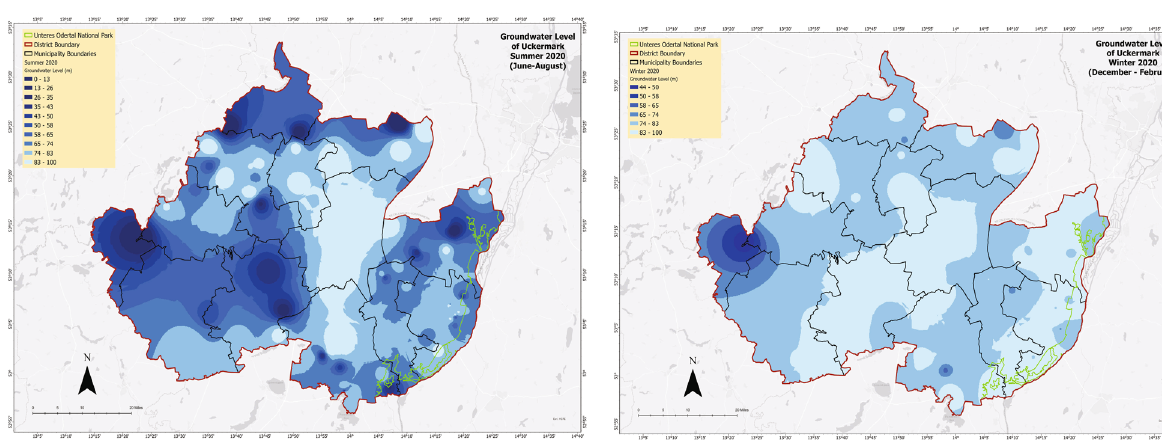
Figure 14. Groundwater level conditions of two seasons (2020) in